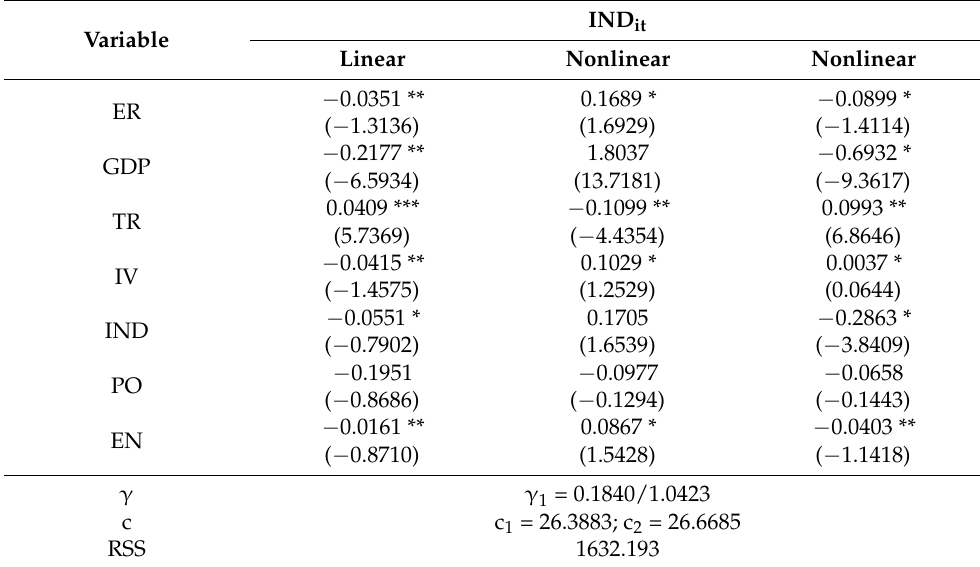
Table 8. PSTR results with industrial structure as the threshold variable.